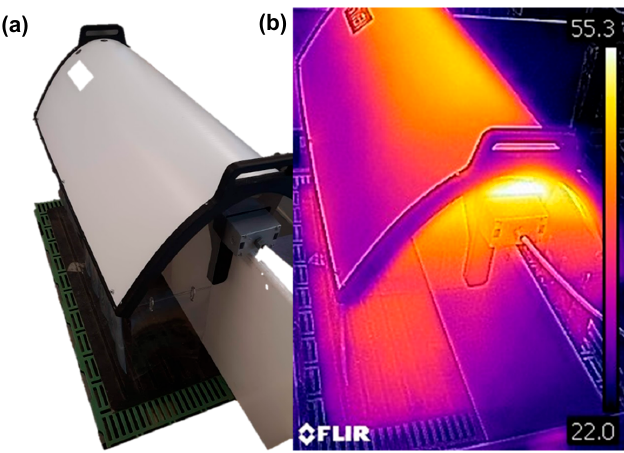
Figure 1. Picture of semi-enclosed heated microclimate (SEHM) for creep area supplementary heat with heating element and enclosure that rest on the creep area divider between two farrowing stalls ( a ). Thermographic image (scale units = °C) of a SEHM at operational conditions ( b ).